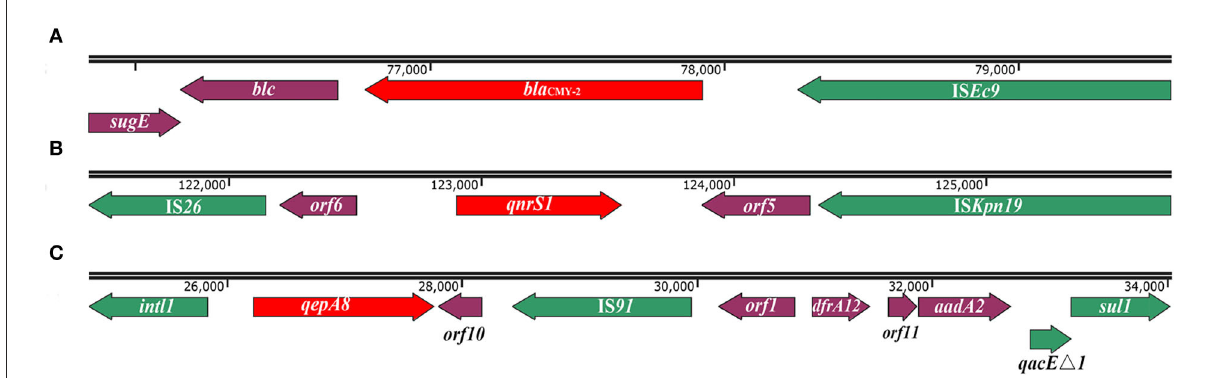
FIGURE2 Schematic of genetic context of bla CMY − 2 , qnrS1 , and qepA8 genes in S. Thompson 17Sal009. (A) The genetic context of bla CMY − 2 gene. (B) The genetic context of the qnrS1 gene. The orf5 is predicated to encode recombinase family protein, and orf6 is predicated to encode transposase. (C) The genetic context of the qepA8 gene. The orf1 is predicted to encode an uncharacterized site-specific integrase, orf10 is predicted to encode mechanosensitive ion channel, and orf11 is predicated to encode DUF1010 domain-containing protein. The arrows indicate open reading frames. Green colors depict mobile genetic elements. Red colors depict bla CMY − 2 , qnrS1, and qepA8 genes.